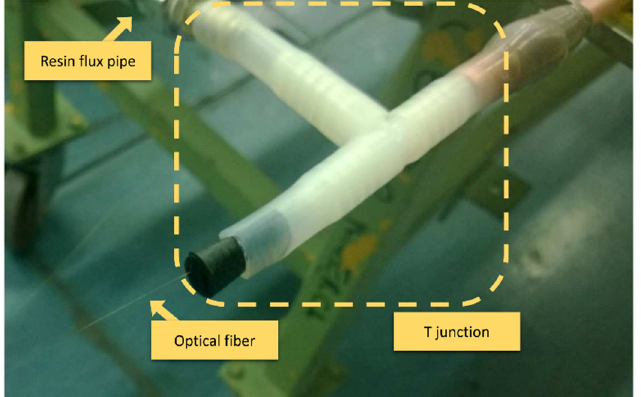
Figure 7. Fiber optic connected though T connector.